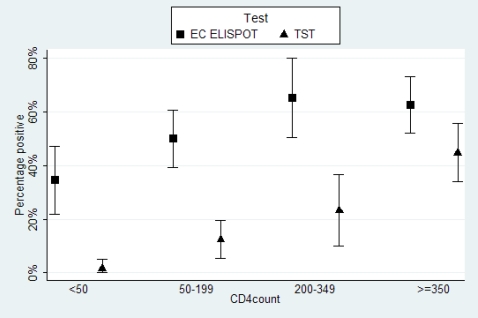
Percentage of positive responders to ESAT6/CFP10 ELISPOT and to TST, by CD4 cell count (n = 247).